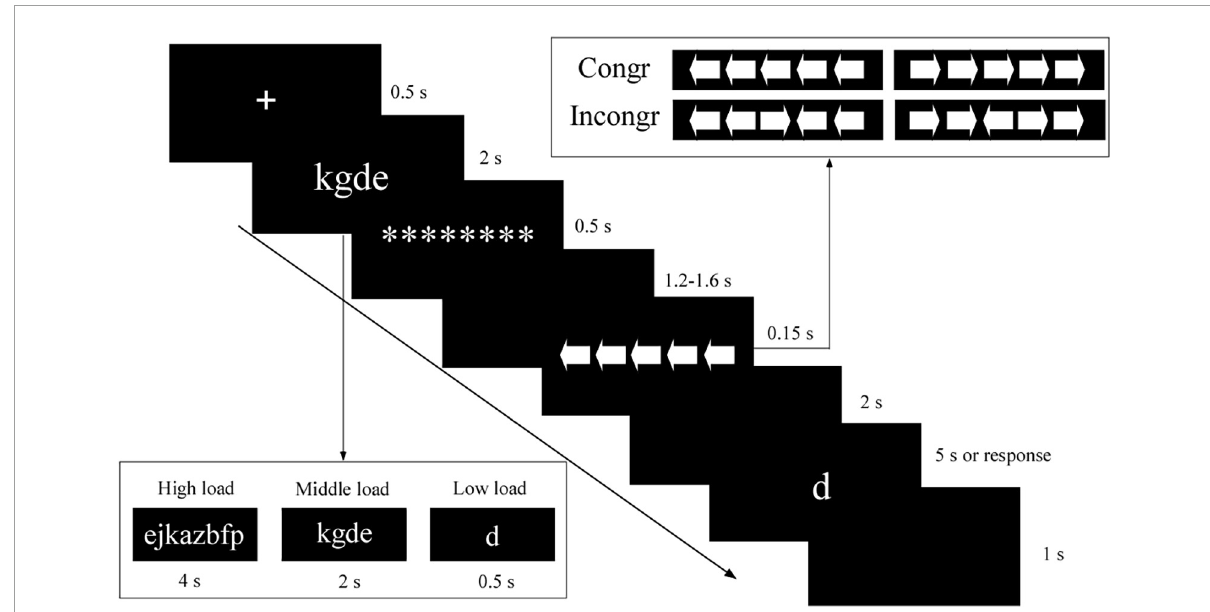
FIGURE1 Task design. An example of a congruent trial in the middle WM load. Low load, low WM load; middle load, middle WM load; high load, high WM load; Incongr, incongruent trials; Congr, congruent trials; ********, a masking array with a row of eight